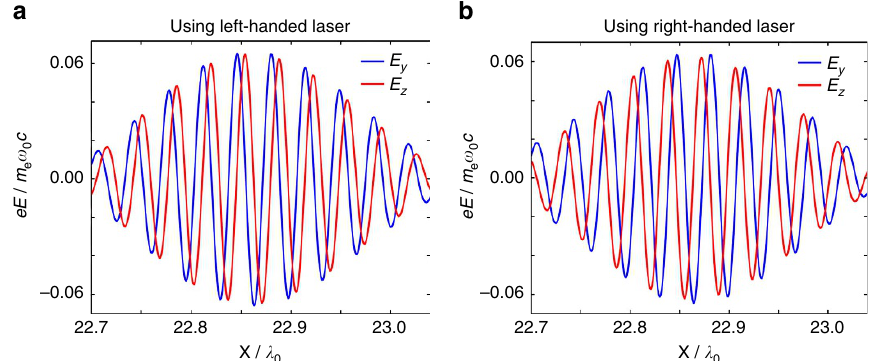
Figure 4 | Switching the harmonic handedness. Electric field waveform of the harmonics using a laser with helicity of ( a ) left-handedness and ( b ) right-handedness. Spectral filtering is applied where the 15th–20th harmonic orders are selected. The laser amplitude is a 0 ¼ 5 and the incidence angle is y ¼ 40 (cid:2) . The plasma density is n e ¼ 200 n c with a scale length of L s ¼ 0.1.